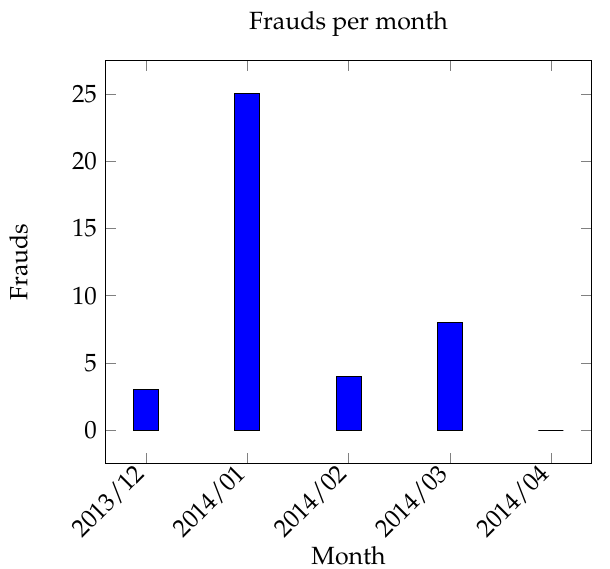
Figure 3. Frauds per month on Dataset 1.